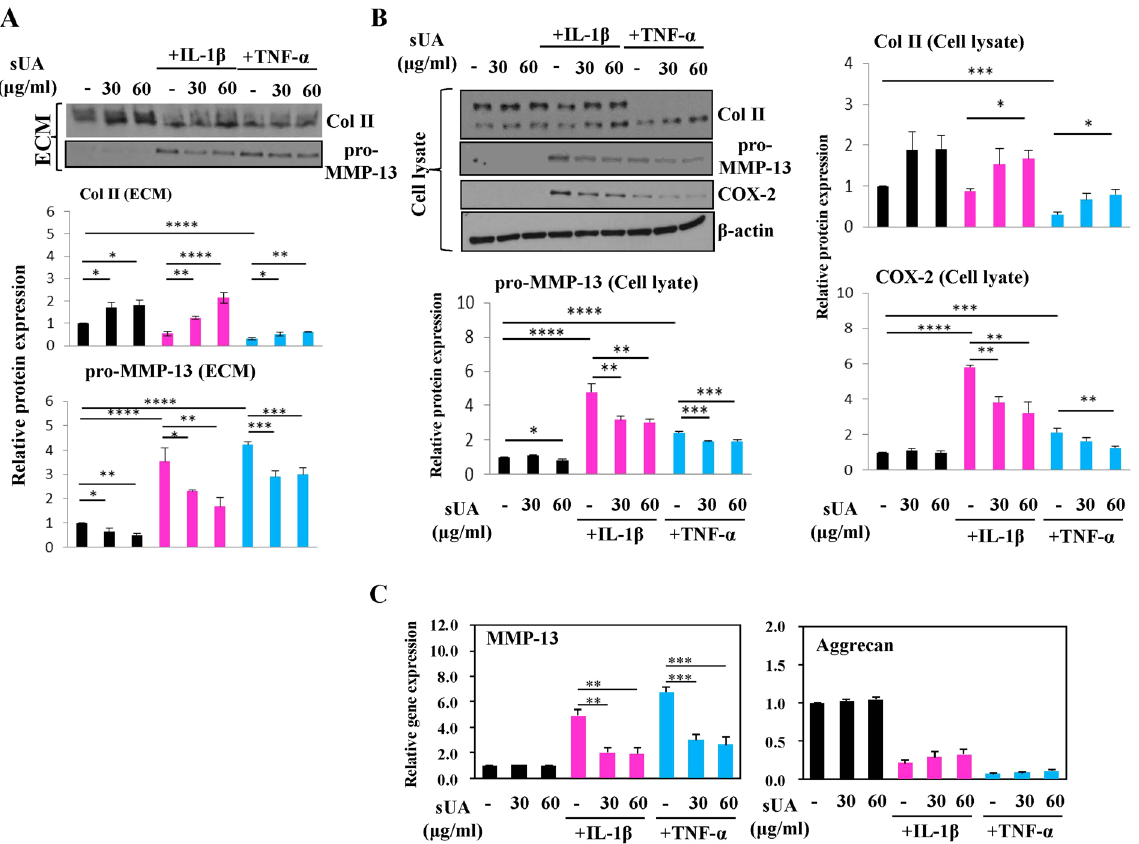
Figure 4. Effects of sUA on TNF- α - and IL-1 β -stimulated chondrocytes cultured in alginate beads. Similar to